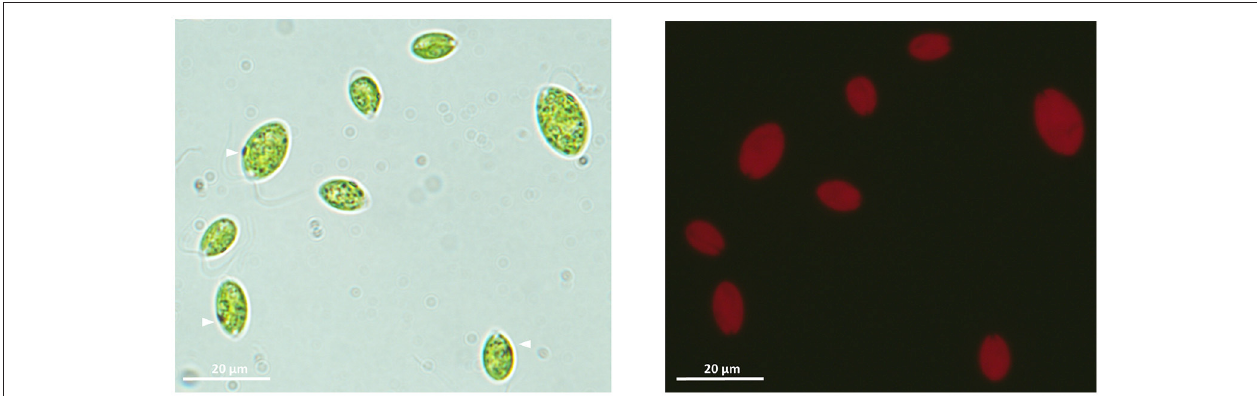
FIGURE 1 | Light microscope (100 × ) images of the ChlSP microalgae isolated from Saelices mine tailings ponds. Left-hand image, vegetative single cells with the apical flagellar end (arrowheads point to the photoreceptor-organelle eyespot). Right-hand image, chlorophyll auto-fluorescence of vegetative ChlSP